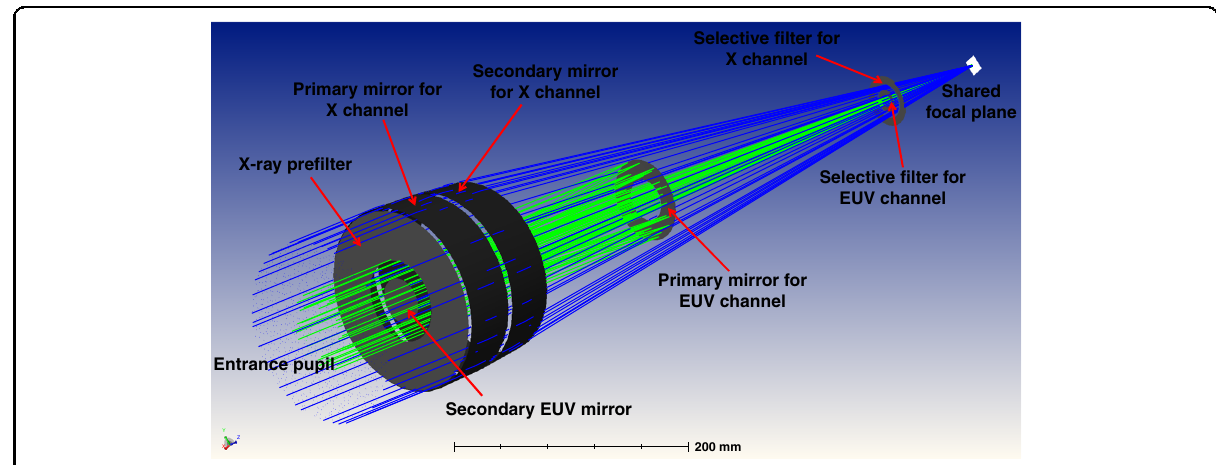
Fig. 10 Optical path of dual-band optics in the X-ray and EUV